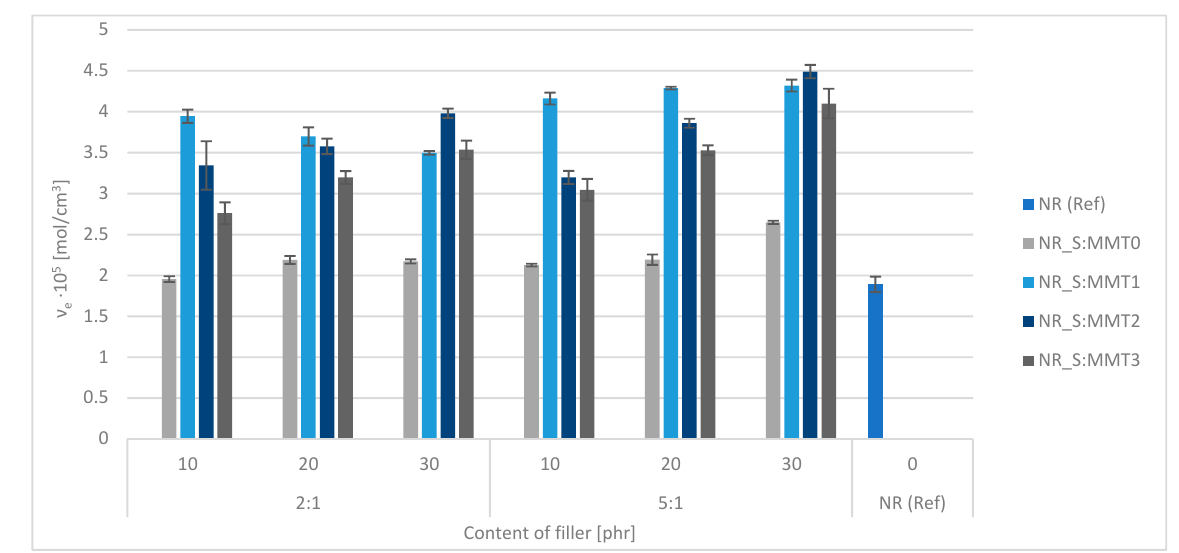
Figure 5. Cross-linking densities ( ν e ) of the tested vulcanizates containing straw fillers with the addition of